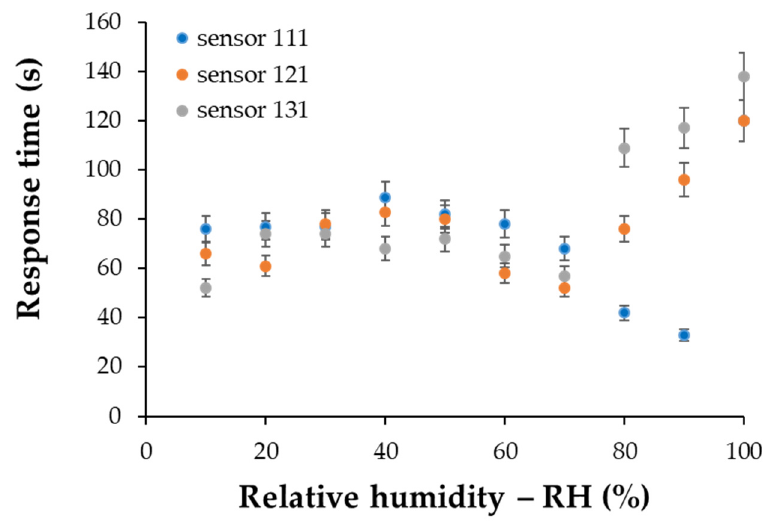
Figure 17. Response time vs. relative humidity (RH %) for sensor 111, sensor 121, and sensor 131.